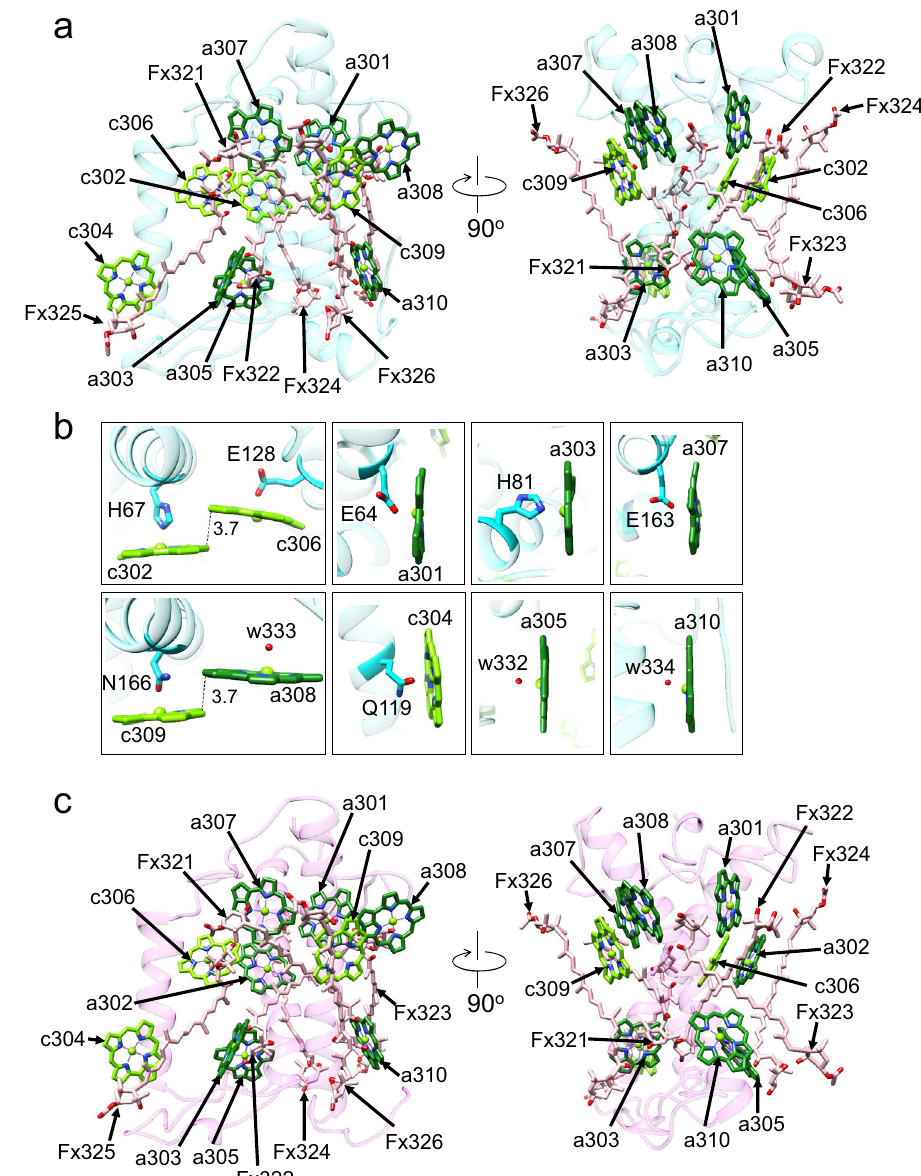
Fig. 2 Structure of the characteristic subunits in the S-tetramer. a Structure of Sm1-Fcpb1 depicted with C α atoms and arrangement of the pigments (Chls and Cars), with the right-side panel rotated 90° clockwise relative to the left-side panel. The pigments of Chl a , Chl c , and Fx are colored “ forest green ” , “ bright green ” , and “ pink ” , respectively. Only the rings of Chls are depicted. b Characteristic ligands to the Mg atom in each Chl molecule. Interactions are indicated by black dashed lines and numbers are distances in Å. c Structure of Sm2-Fcpb2 and arrangement of the pigments (Chls and